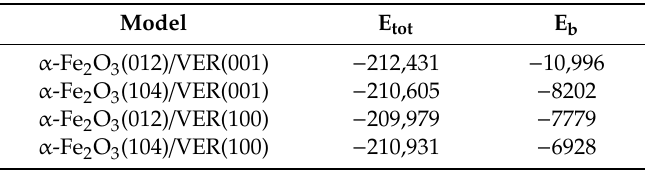
Table 2. Total potential energies (E tot ) and binding energies (E b ) for optimized α -Fe 2 O 3 / vermiculite models. Energies are expressed in kcal / mol.